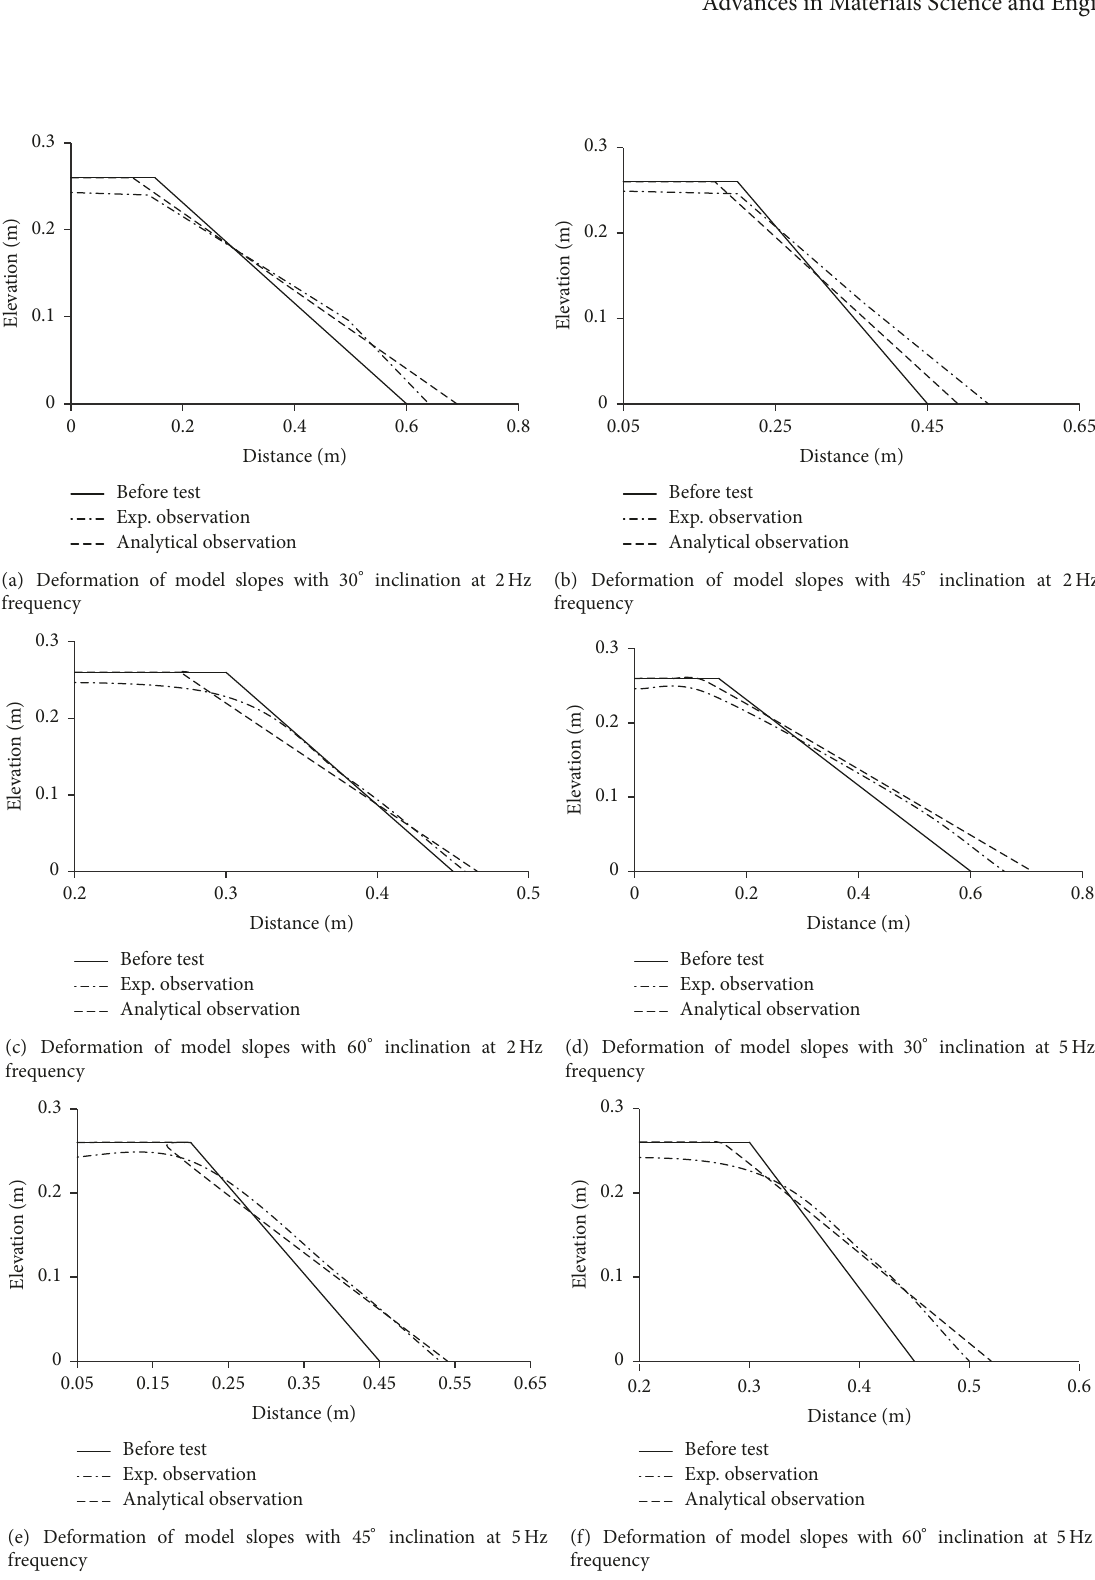
Figure 9: Deformation of model slope measured and pattern of failure surface during shake table test and pseudodynamic analysis of slope made up of S + 30% SD for frequency 2 Hz and 5 Hz at water content